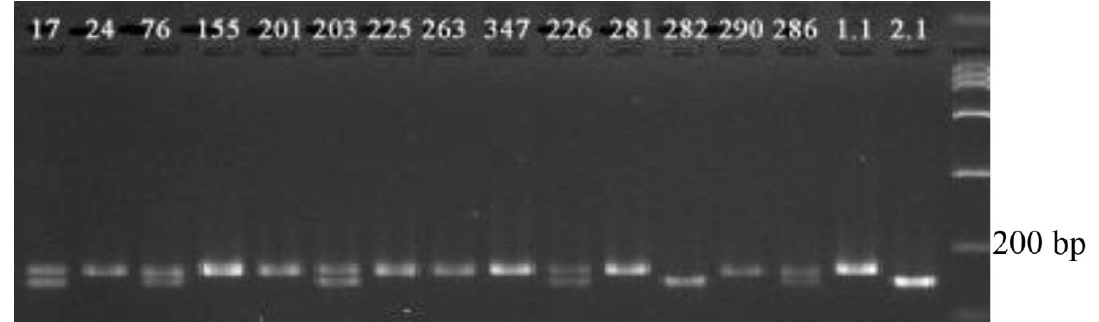
Figure 7. Electrophoregram of genomic DNA amplification products with RM 7075: 1.1, Novator; 2.1, NSIC Rc 106; 17–286, hybrid plants NSIC Rc 106 × Novator; DNA marker (100–1500 bp).